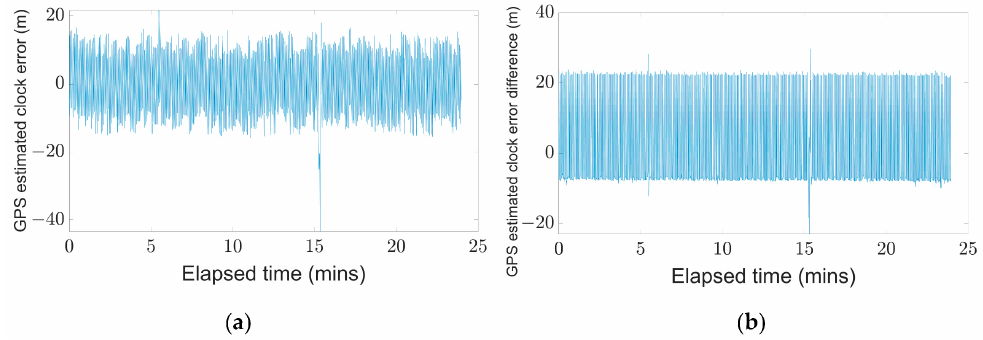
Figure 15. Time series of estimated GPS clock offset and corresponding clock difference. ( a ) Estimated GPS clock offset. ( b ) Estimated GPS clock difference of adjacent epochs.